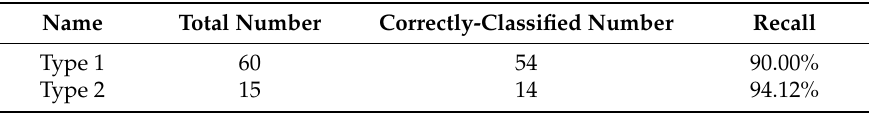
Table 1. Number and recall of different types of airports.